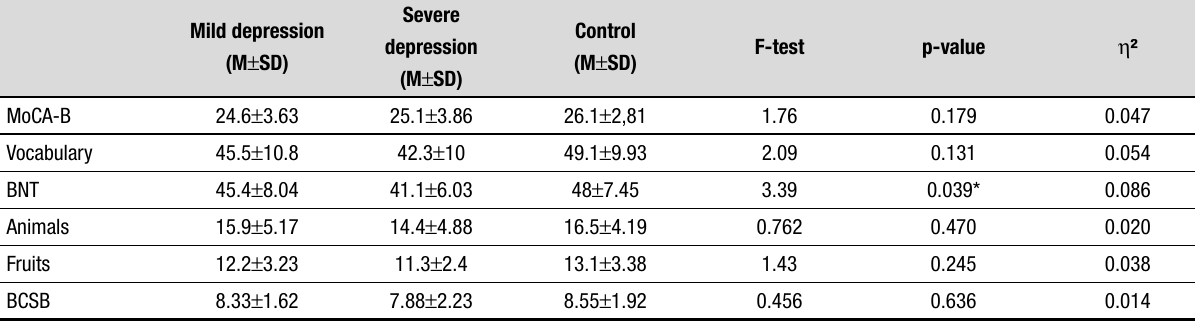
Table 3. Comparison between the clinical groups and the control group about applied